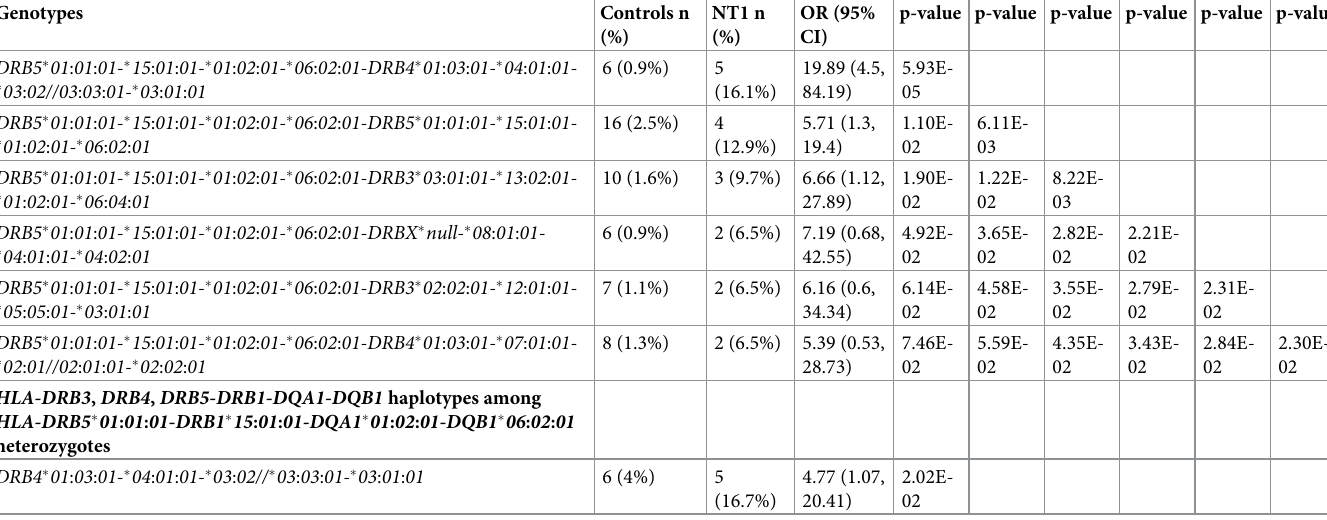
Table 3. HLA-DRB3 , DRB4 , and DRB5-DRB1-DQA1-DQB1 genotype frequencies among NT1 patients (n = 31) and population controls (n = 636). Genotypes Controls n